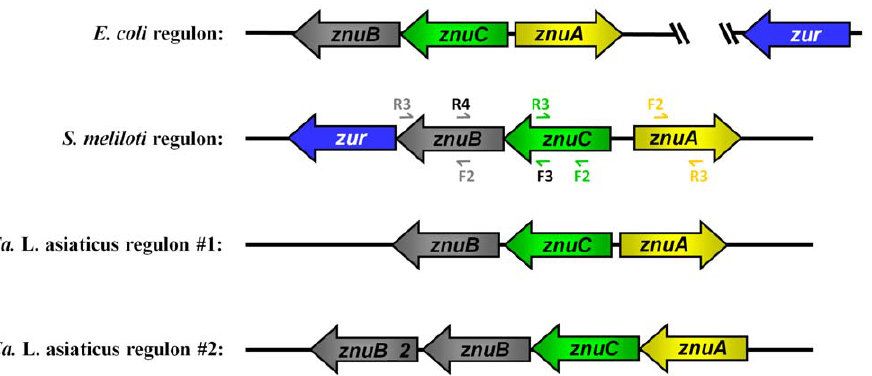
Figure 1. Schematic comparison of the Znu gene cluster from E.coli,S.meliloti and Ca. Liberibacter asiaticus. Znu homologues have been identified in the two intracellular-plant bacterium, S. meliloti and Ca. Liberibacter asiaticus. The arrangement of znuA, znuB, and znuC genes in each bacterium are shown. A BLAST search of the completed genomes revealed that only the E. coli and S. meliloti gene clusters contain the zinc uptake regulator, zur. In E. coli, the zur gene is located 2.2 Mb downstream of znuA while in S. meliloti it is immediately upstream of znuB . Primers are depicted as small arrows and are colored coded to represent the genes in which they are located. Notations above the primers correspond to the final letters in the primer name and are colored according to the genes that they amplify. Names of primers that were used to cross the junction of a gene are listed in black.